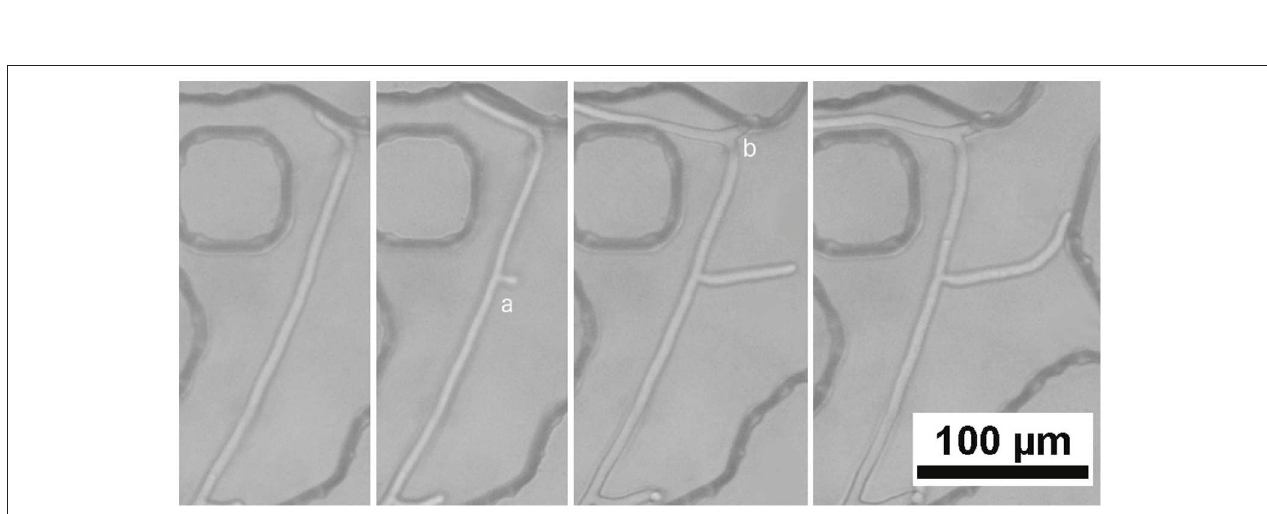
FIGURE 7 | Location and time sequence of the branching of a hypha. (a) at this point, immediately preceding a septum, branching seems to be very much like that observed in Petri dishes or in the inlet portion of the micromodel, whereas at (b) the branching seems to be closely associated with the strong bending of the hypha.